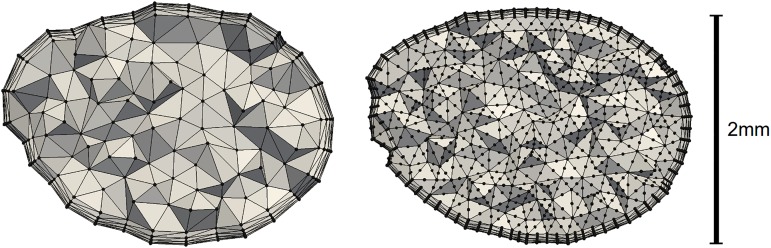
Flow profile used in the simulations.